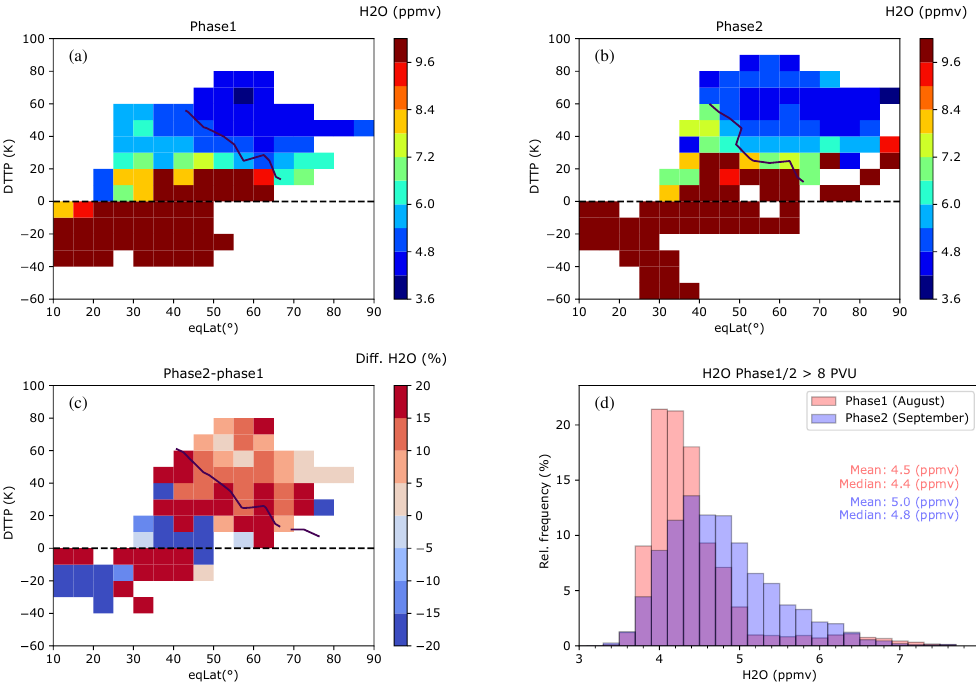
Figure 2. Mean distribution of H 2 O as a function of equivalent latitude and distance to thermal tropopause (DTTP) in potential temperature units: (a) phase 1 and (b) phase 2. (c) Relative differences of H 2 O between phase 2 and phase 1. The dashed/solid black lines represent the thermal tropopause and the 8PVU isoline, respectively. (d) Frequency distribution of H 2 O for the lower stratosphere (PV > 8PVU) for phase 1 (red) and phase 2 (blue). The mean and median values of each distribution are given in red and blue, respectively.